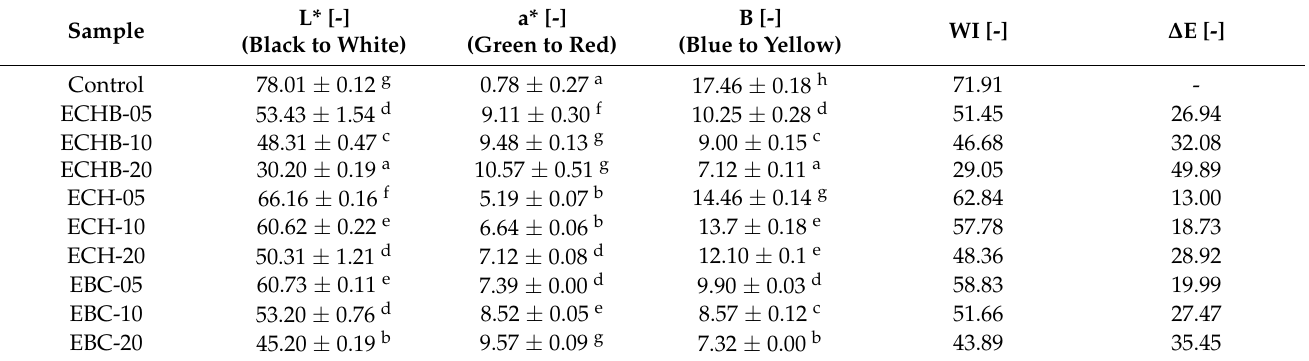
Table 6. Color parameters of corn extrudates with addition of fruit pomace.